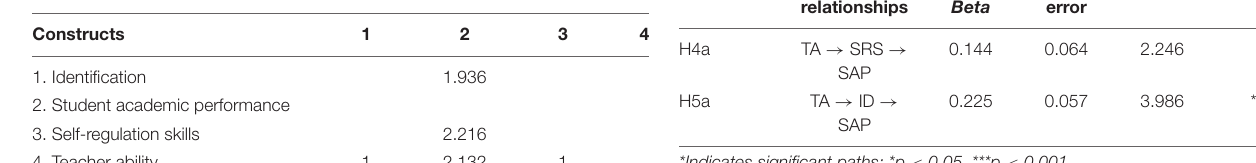
TABLE 4 | Variance influence factor.